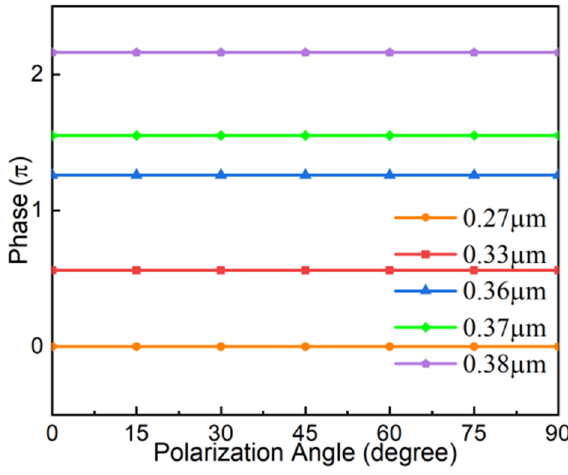
Figure A2. The veri fi cation of the polarization-maintaining performance for the nanocolumn. From the above fi gure, we can know that the phase of the unit cell under the FIT method simulation also does not change with the polarization angle of the incident light, which shows the phase consistency of the metasurface under x-line polarized light incidence and y-line polarized light incidence.